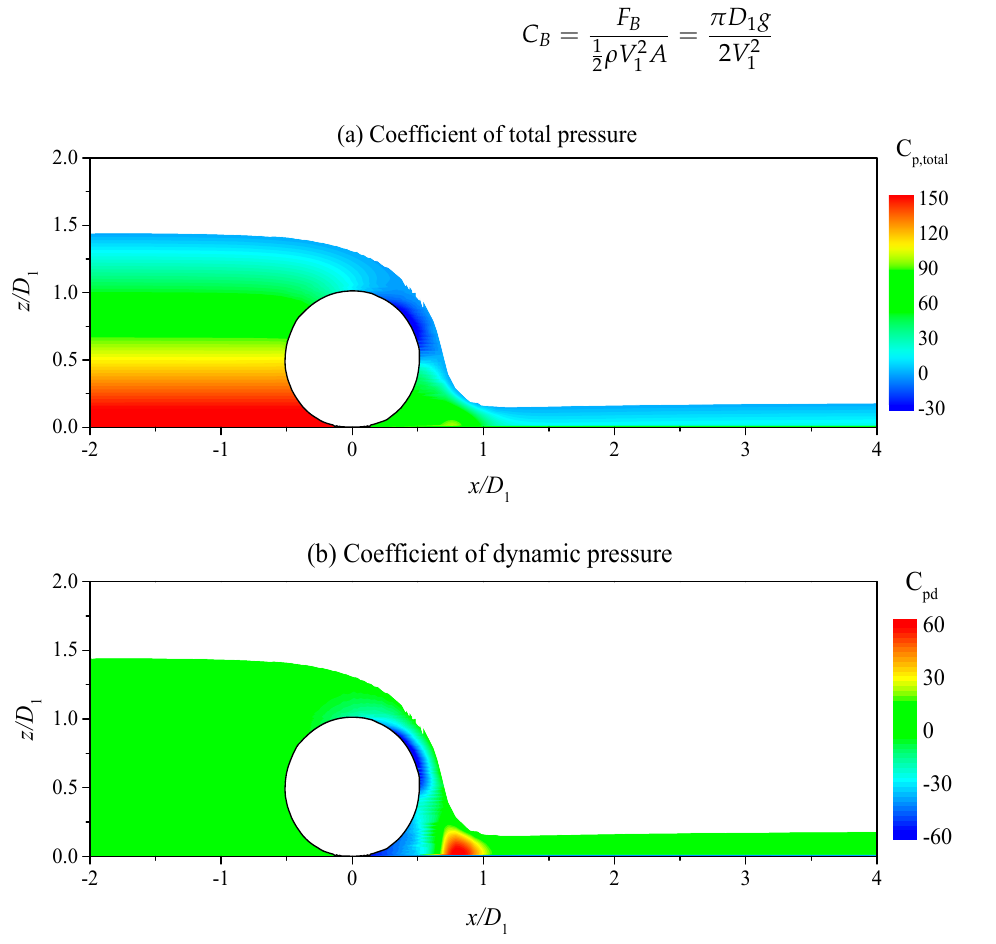
Figure 6. Distribution of pressure coefficients on the centerline of the circular dam for the validation case (Case A1). ( a ) Total pressure; ( b ) dynamic pressure.